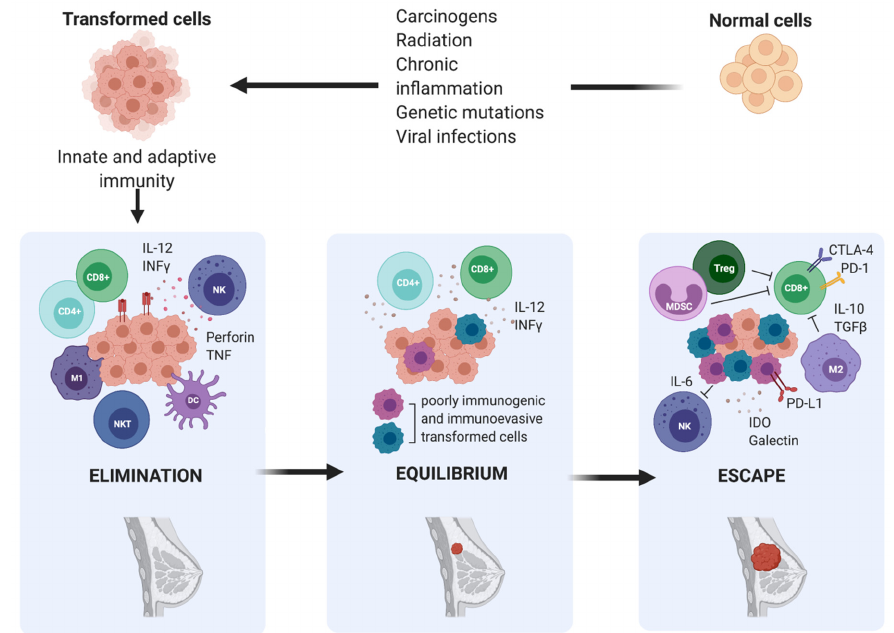
Figure 2. The three phases of cancer immunoediting in breast cancer. Elimination is the first phase of cancer immunoediting. Early in mammary tumorigenesis, acute inflammation induces the activation of innate immunity, including type 1- polarized macrophages (M1), natural killer (NK), and natural killer T cells (NKT), resulting in both tumour cell death and the maturation of dendritic cells (DC), which can prime tumour-specific T cells (CD4 + and CD8 + ). Inflammation-related soluble factors, including IL-2, IFN γ , perforin, and TNF, can be found in the TME. This stage is followed by either immune-mediated rejection of incipient tumours or the selection of tumour cell variants, which can induce chronic inflammation. Hence, the persistent cells enter the equilibrium phase. Ultimately, this leads to the escape phase, which results in a complex and immune-tolerant TME, consisting of suppressive immune cells, including regulatory T cells (Treg), type 2- polarized tumour-associated macrophages (M2), and myeloid-derived suppressor cells (MDSC), and inhibitory molecules such as IL-6, IDO, galectin, IL-10, and TGF- β , that allow overt immune escape and tumour progression to occur.